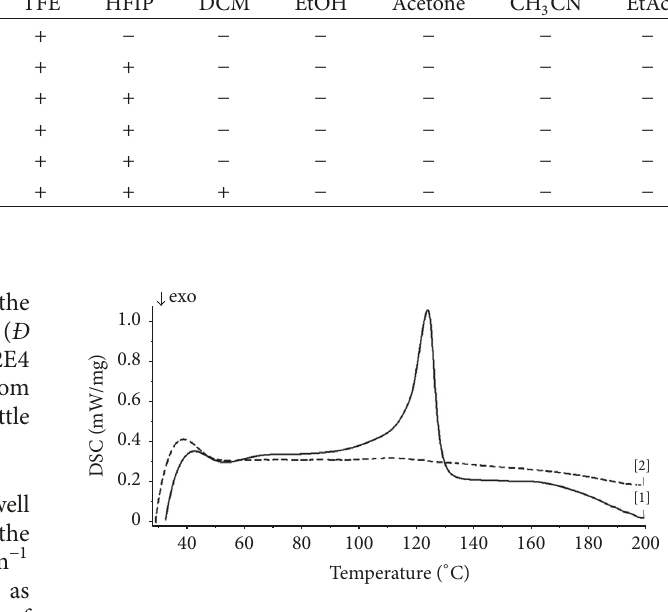
Figure 7: The representative DSC profile of the click PE PE8E4: [1] , the first heating scan; [2] , the second heating scan after a heating- cooling